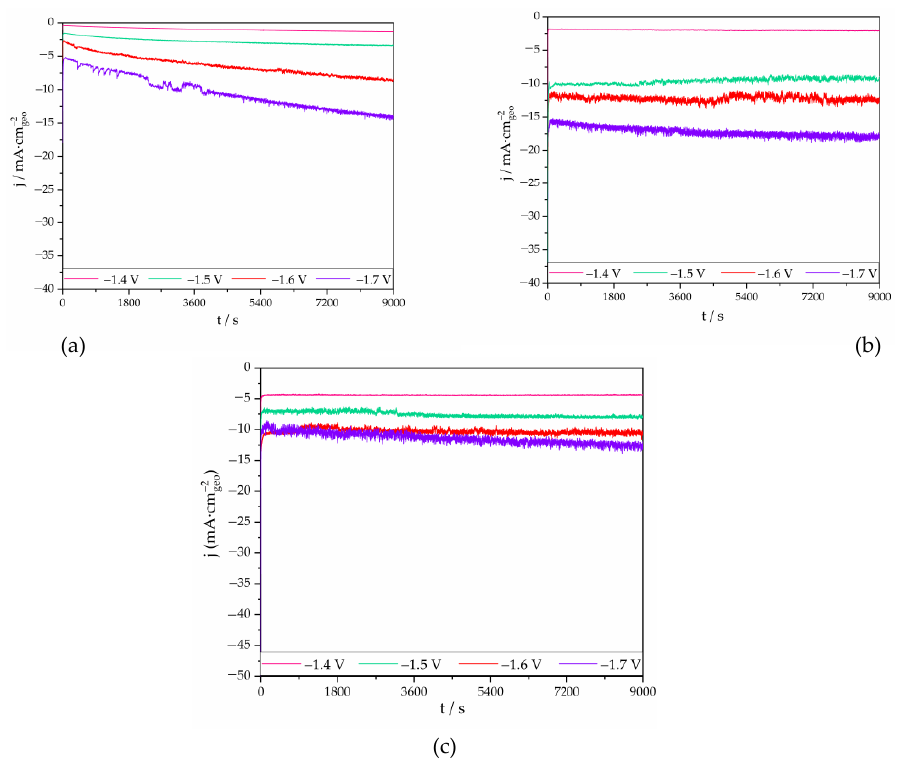
Figure 8. Chronoamperometric measurements at − 1.4, − 1.5, − 1.6 and − 1.7 V vs. Ag/AgCl, for: ( a ) In KOH ; ( b ) In 20 /C 80 ; ( c ) In 50 /C 50 catalyst.